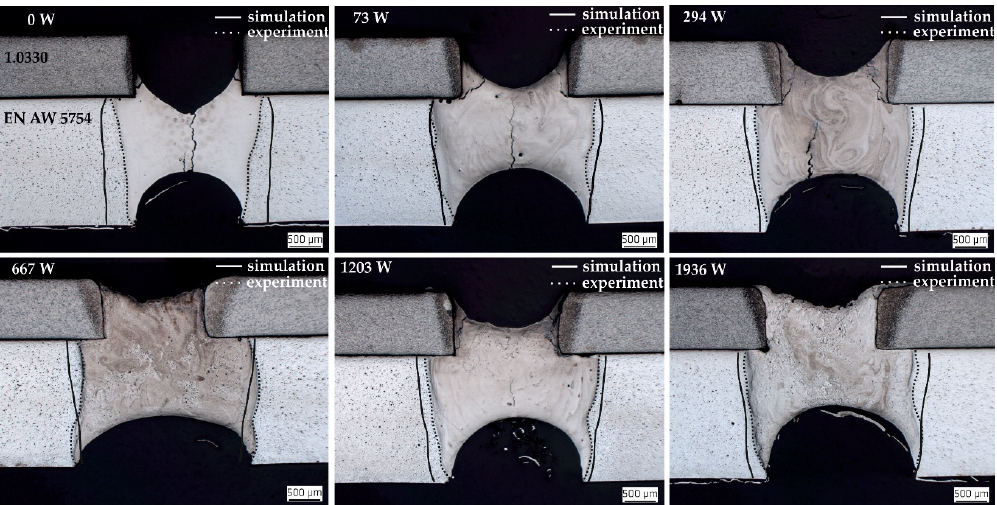
Figure 15. Comparison of numerical and experimental results of the melt pool contours of 0 W up to 1936 W magnet power.